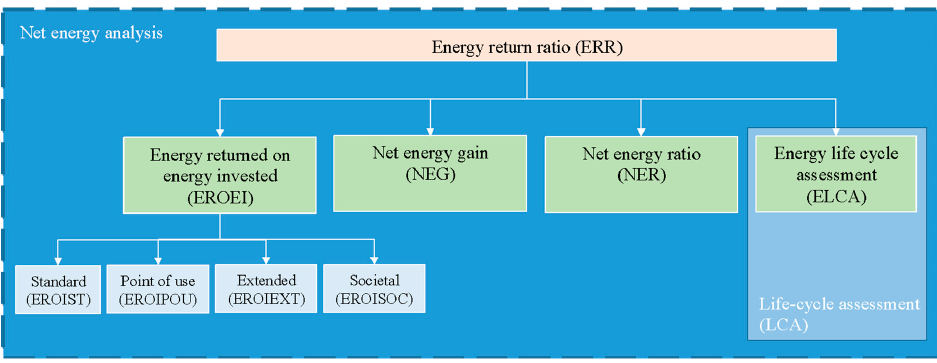
Figure 1. The hierarchical structure and the relationship among the considered energy efficiency indices. Source: own elaboration.